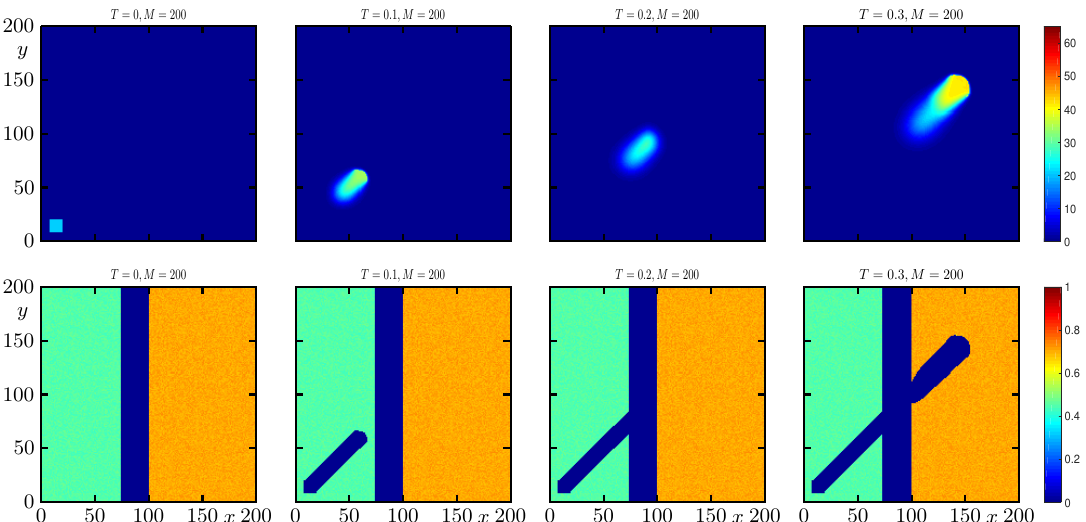
Figure 7. Example 3: Evolution of the dynamics of temperature ( top ) and fuel ( bottom ). Propagation of fire across a firebreak of insufficient width. Table 3. Example 3: Total amount of available (unburnt) fuel in the denser area at different times.